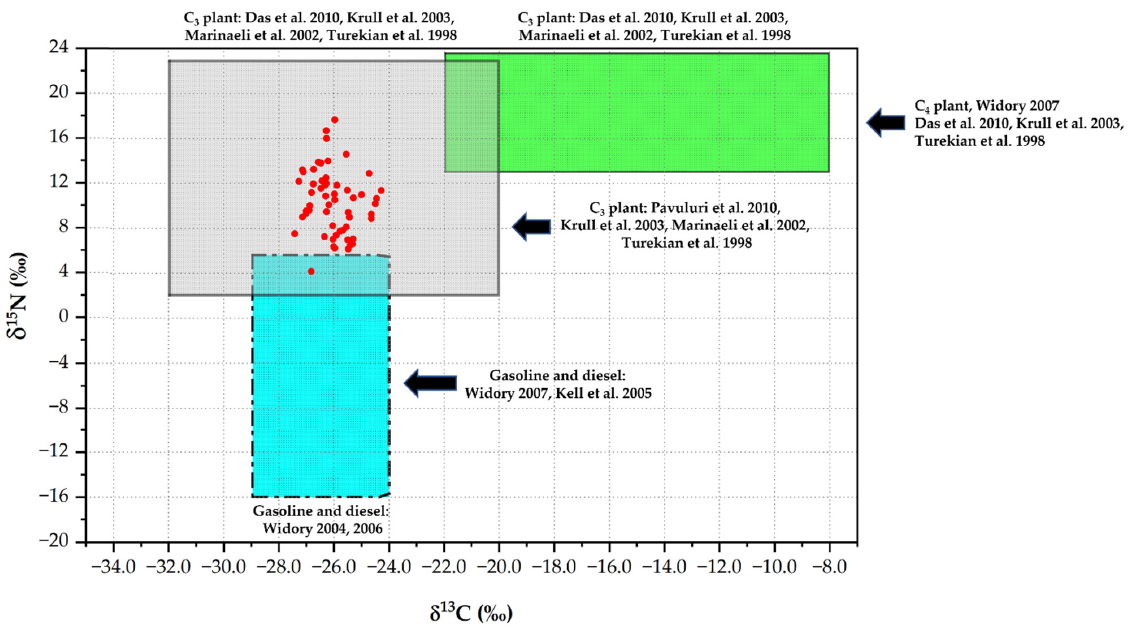
Figure 6. Relationship between δ 13 C and δ 15 N with sign level of potential sources in PM 2.5 [12,24,25, .